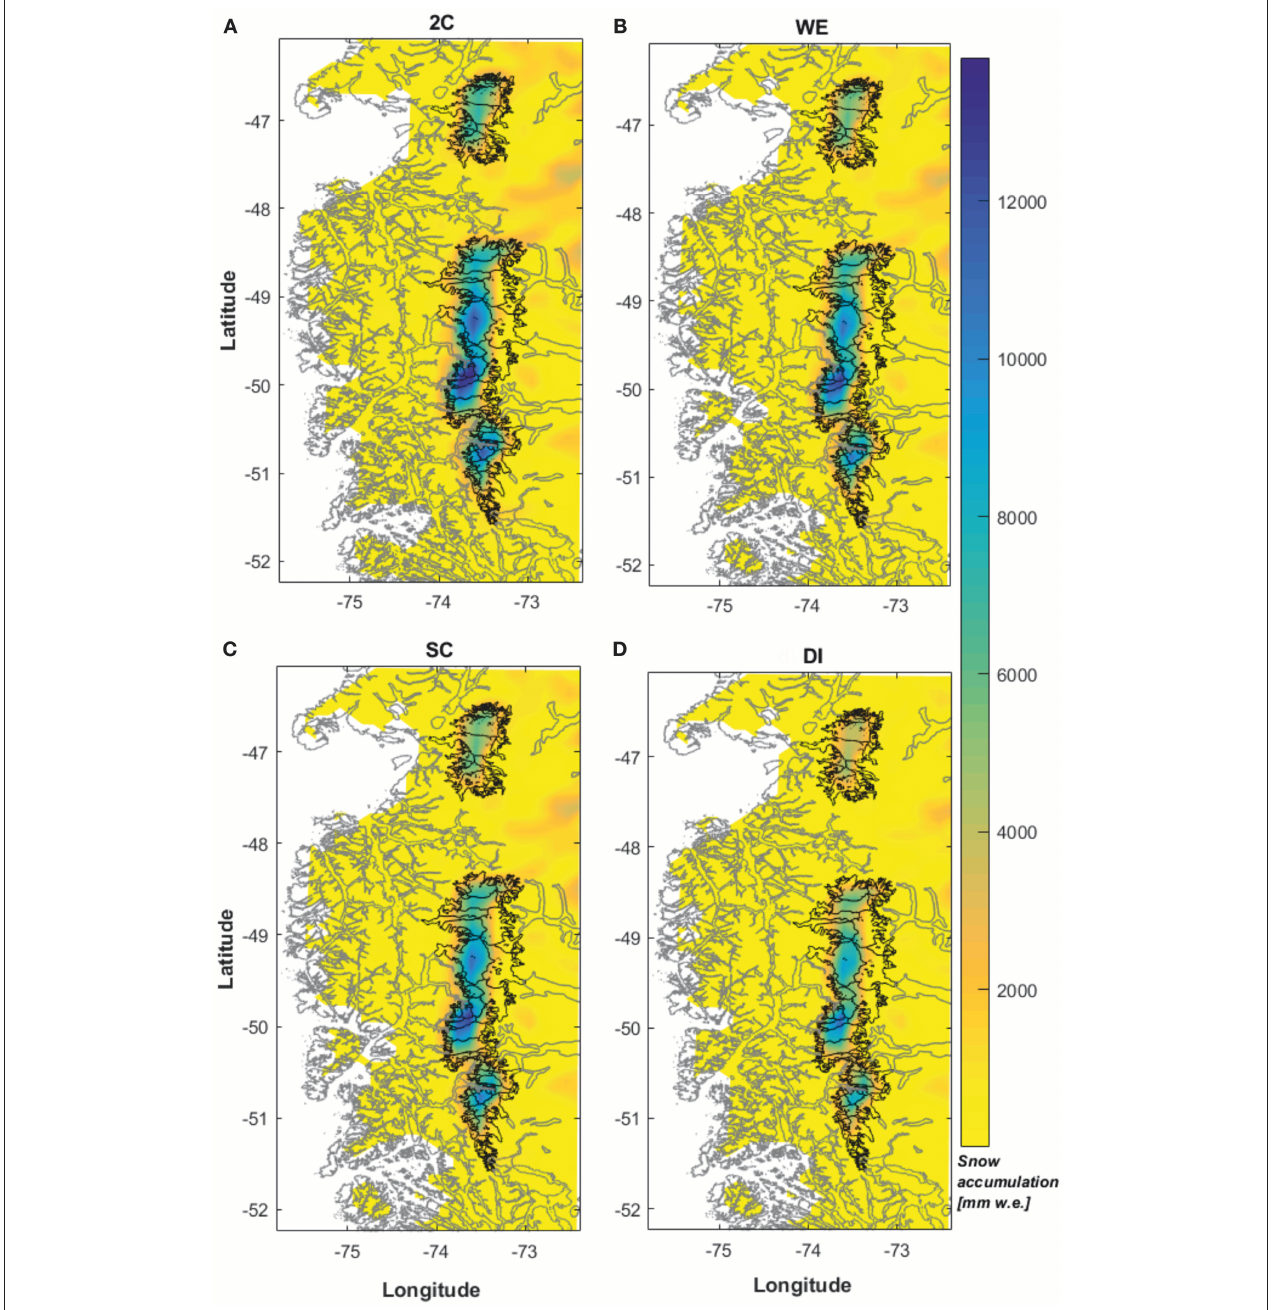
FIGURE 2 | 1980–2015 annual mean value of snow accumulation (mm w.e.) for each PPM. (A) 2C, (B) WE, (C) SC, and (D) DI method. Icefield contours in black were obtained from RGI consortium (2017) and edited using a Landsat 8 image (OLI) of the 8 April 2014. Coastlines are in gray.